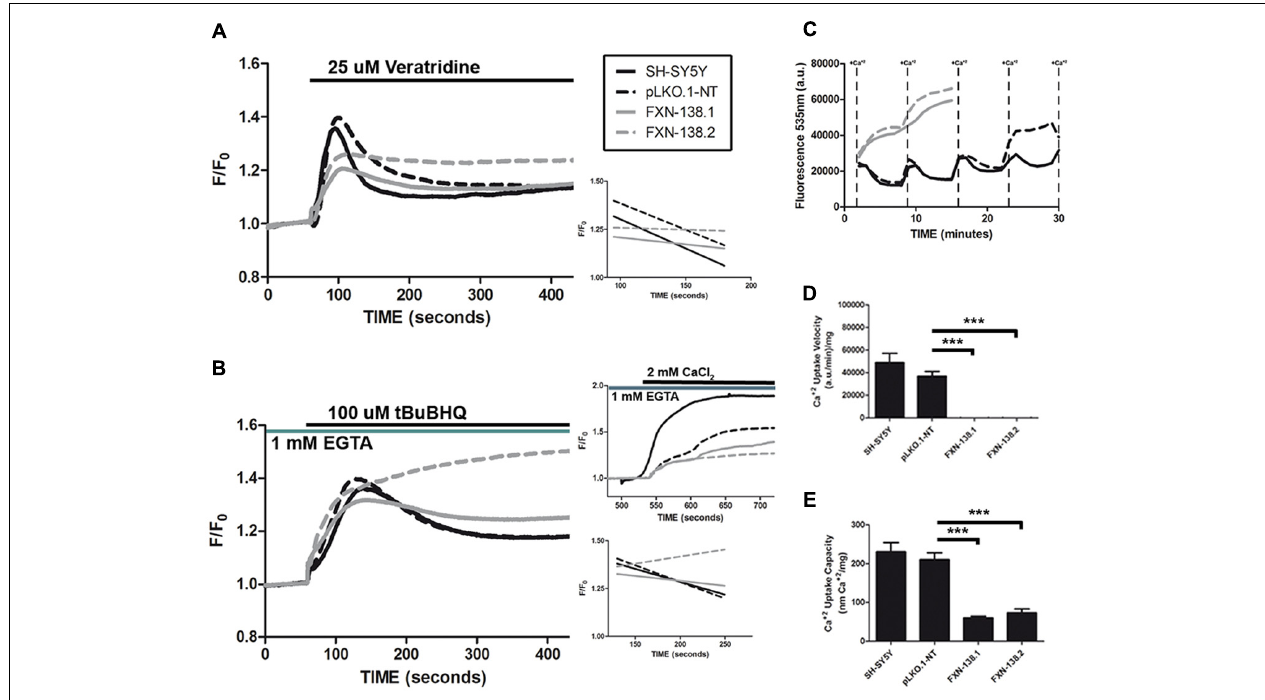
FIGURE 10 | Calcium homeostasis in frataxin-depleted SH-SY5Y cells. (A) Changes in fura-2 [Ca 2 + ] cyt fluorescence intensity after addition of 25 μ M veratridine. The recovery slopes for each clone after calcium entry (right, lower panel) show the difference in behavior for calcium buffering between control and frataxin-depleted clones. Traces represent means of no fewer than 100 cells from at least five experiments. (B) Changes in fura-2 [Ca 2 + ] cyt fluorescence intensity after addition of 100 μ M tBuBHQ in Ca 2 + -free medium. The recovery slopes for each clone after emptying of calcium from the endoplasmic reticulum (right, lower panel) show the different behavior for calcium buffering between control and frataxin-depleted clones. The activation of SOCE with the addition of 2 mM